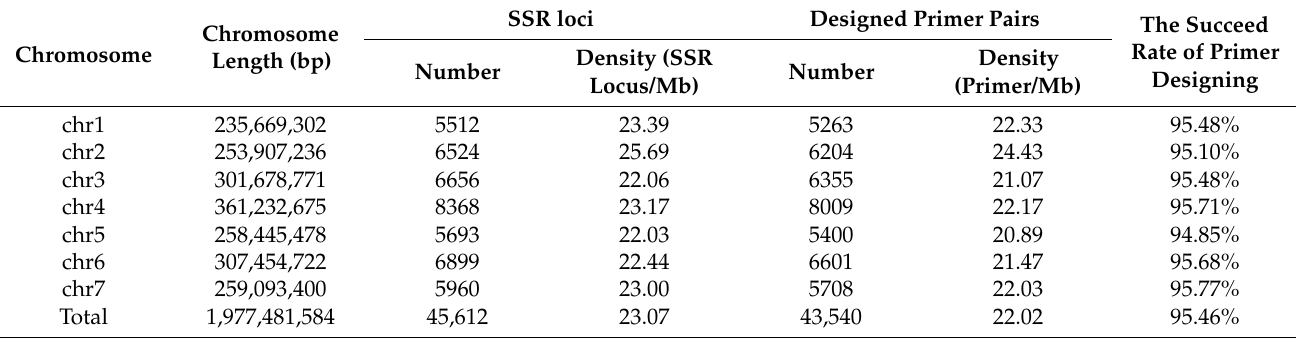
Table 3. The distribution of SSR loci and potential SSR markers on chromosomes of M. incana